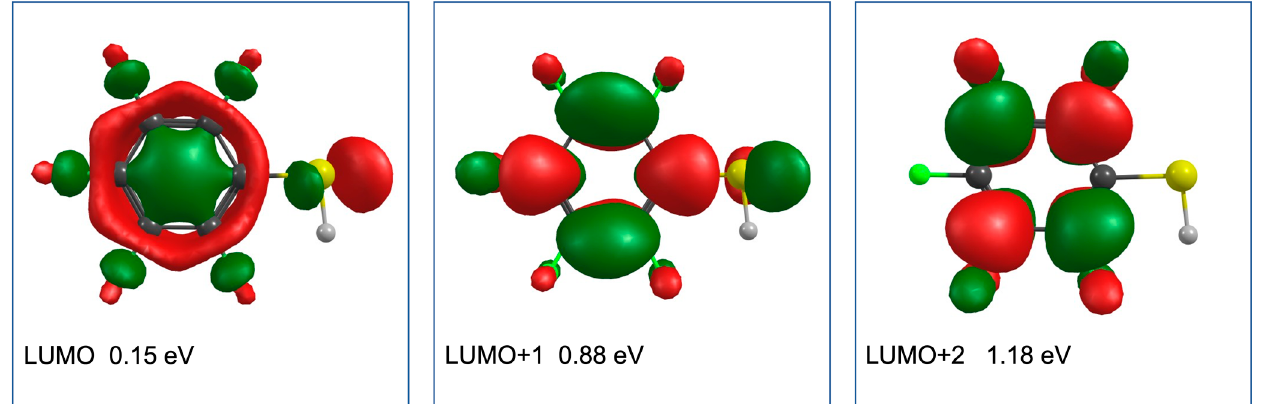
Figure 6. Contour plots of the LUMO, LUMO + 1, and LUMO + 2 of PFTP (B3LYP orbitals). The respective vertical electron attachment energy calculated using the EOM-EA-CCSD method with the B3LYP orbitals and aug-cc-pVTZ basis set are shown for each orbital. The LUMO has a σ * character, while LUMO + 1 and LUMO + 2 have a π * character and correlate with b 1 ( π * ) and a 2 ( π *) MOs, respectively.